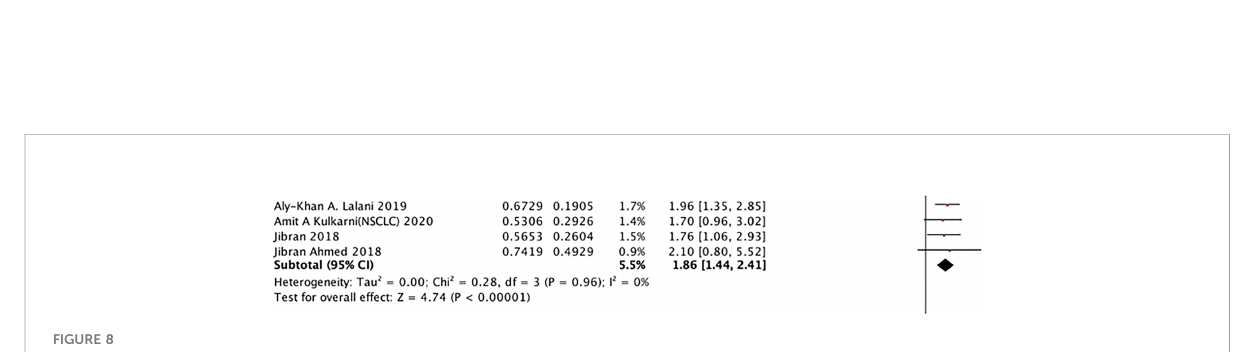
FIGURE 8 In broad- spectrum ATB class, the subgroup analysis between ATB use and PFS of cancer patients treated with